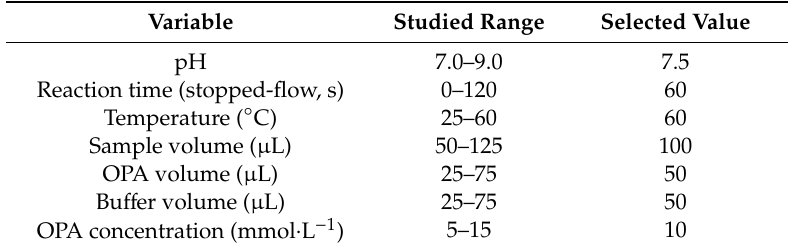
Table 1. Overview of the chemical and instrumental variables.